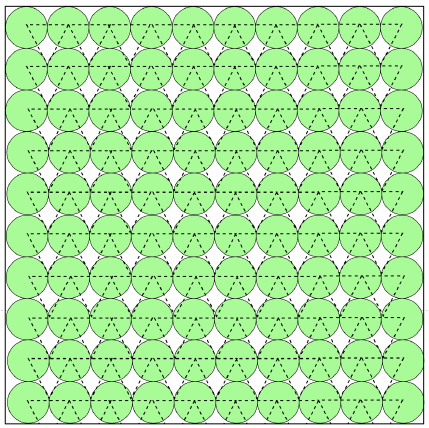
Figure 1. An example of a classical deployment strategy.